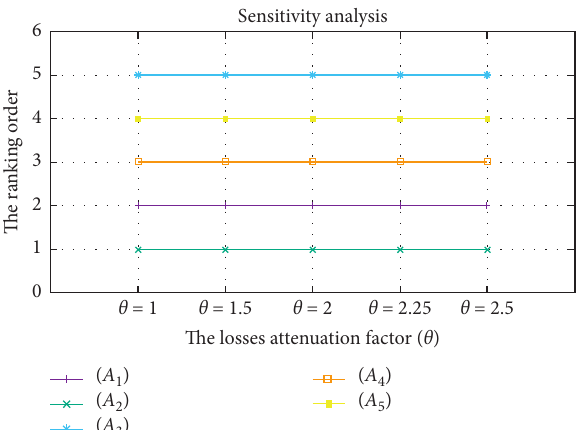
Figure 2: The sensitivity